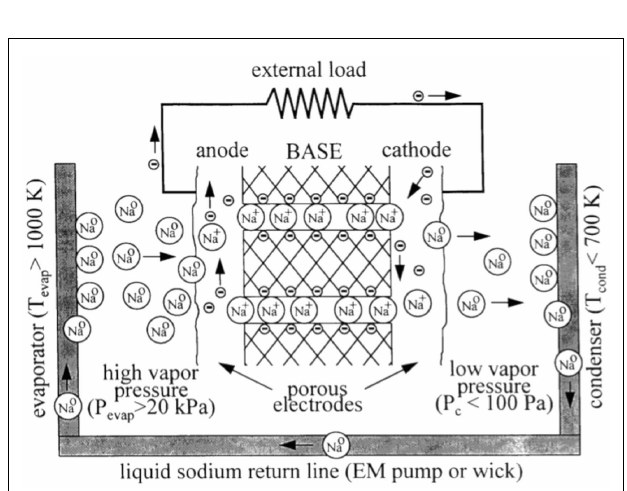
FIGURE 9 |A schematic diagram of sodiumAMTEC operating cycle showing microscopic processes . Reprinted with permission fromTournier and El-Genk